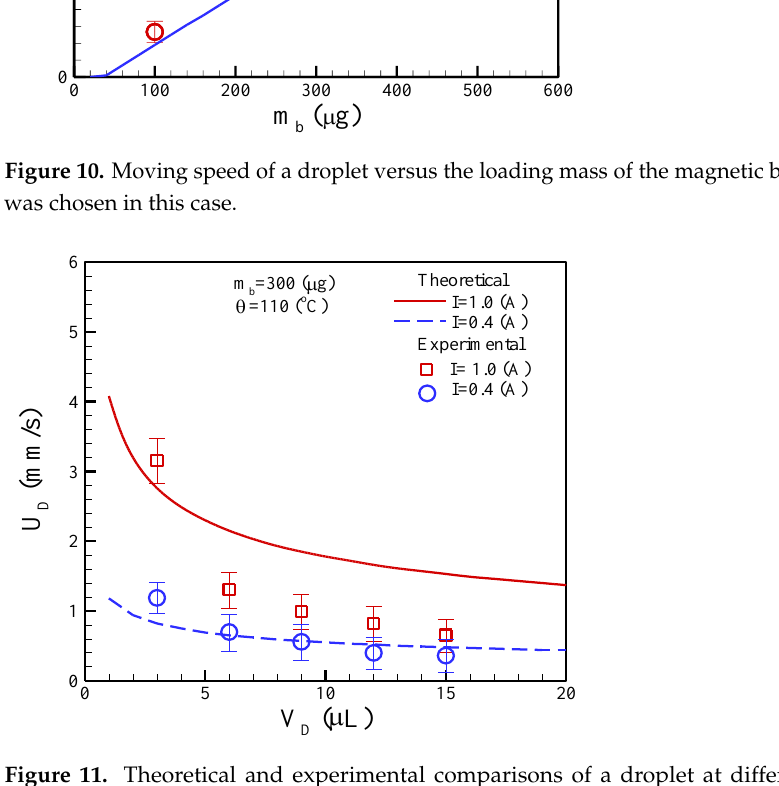
Figure 11. Theoretical and experimental comparisons of a droplet at different volumes versus moving speeds.